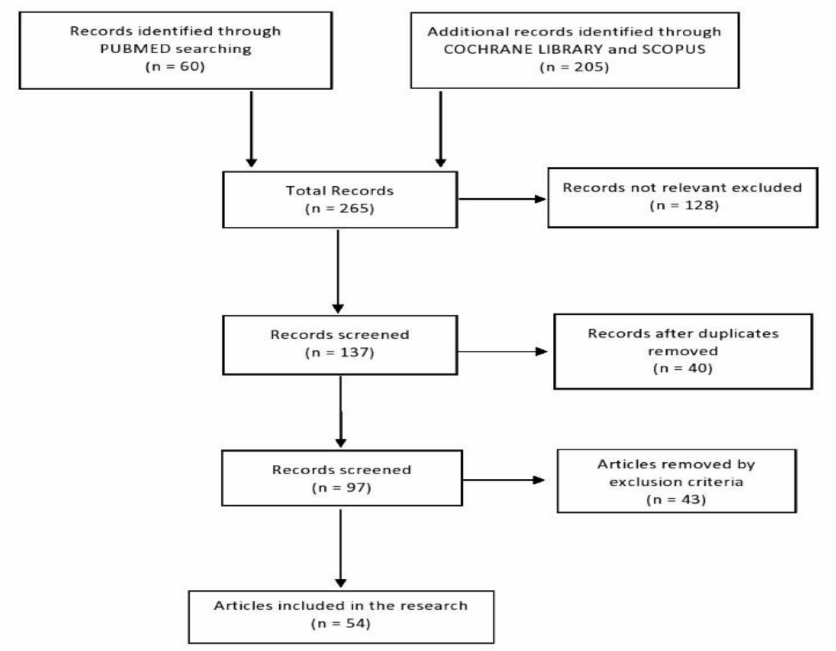
Figure 1. Flow chart of the systematic